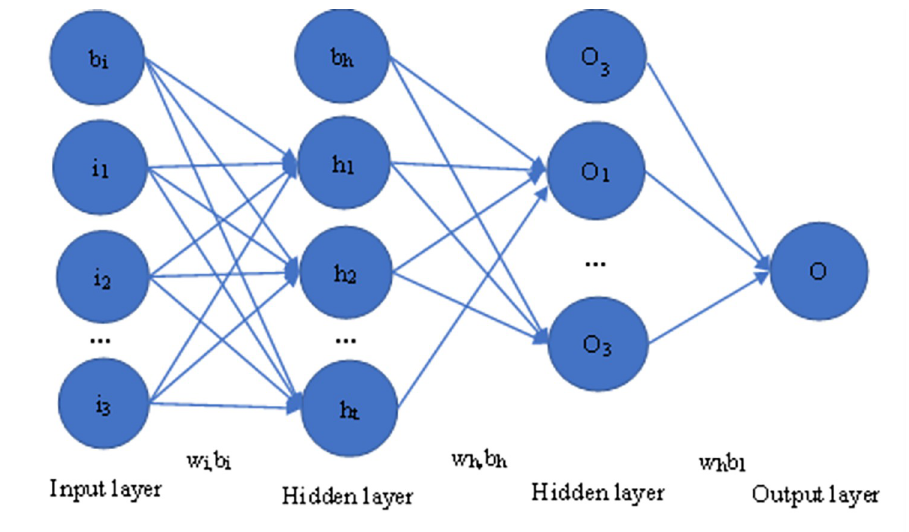
Fig 1. Structural model of the back-propagation neural network